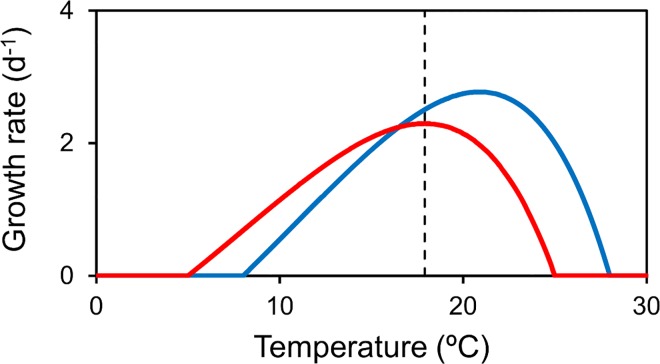
Growth rate vs. temperature.Optimum temperature (Topt) = Red: 18, Blue: 21. See S1 File for parameter values.